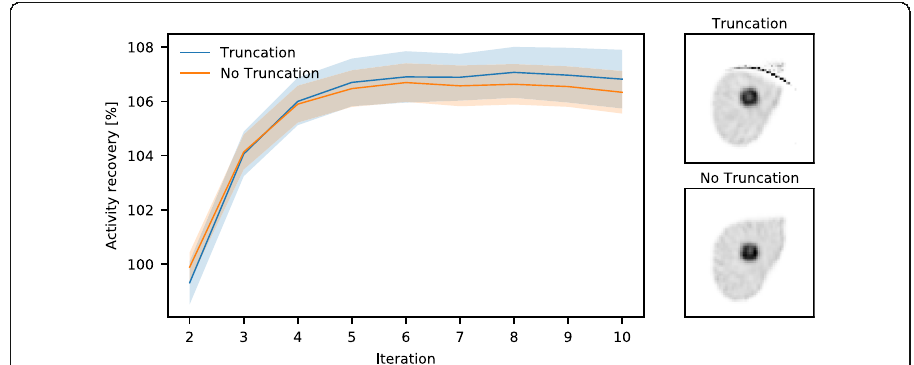
Fig. 9 Activity recovery of reconstructions with and without truncation, for the cone beam (50 cm) collimator reconstructed with Monte Carlo-based scatter correction